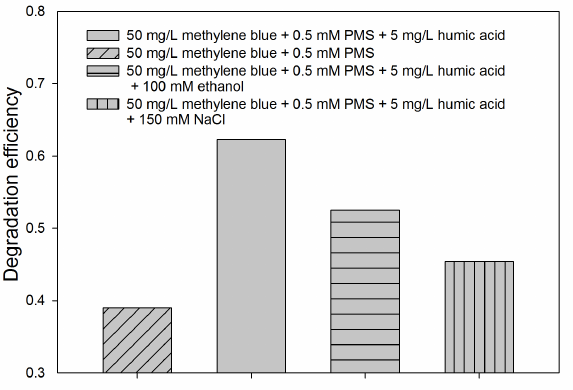
Figure 6: Radical scavenger study for 50 mg/L methylene blue